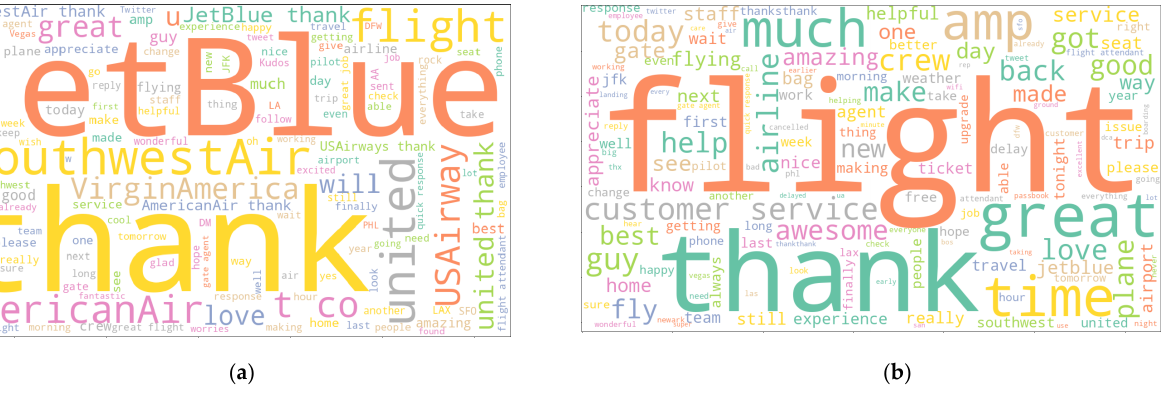
Figure 7. ( a ) Word Cloud of positive tweets—before preprocessing and ( b ) Word Cloud of positive tweets—after preprocessing.